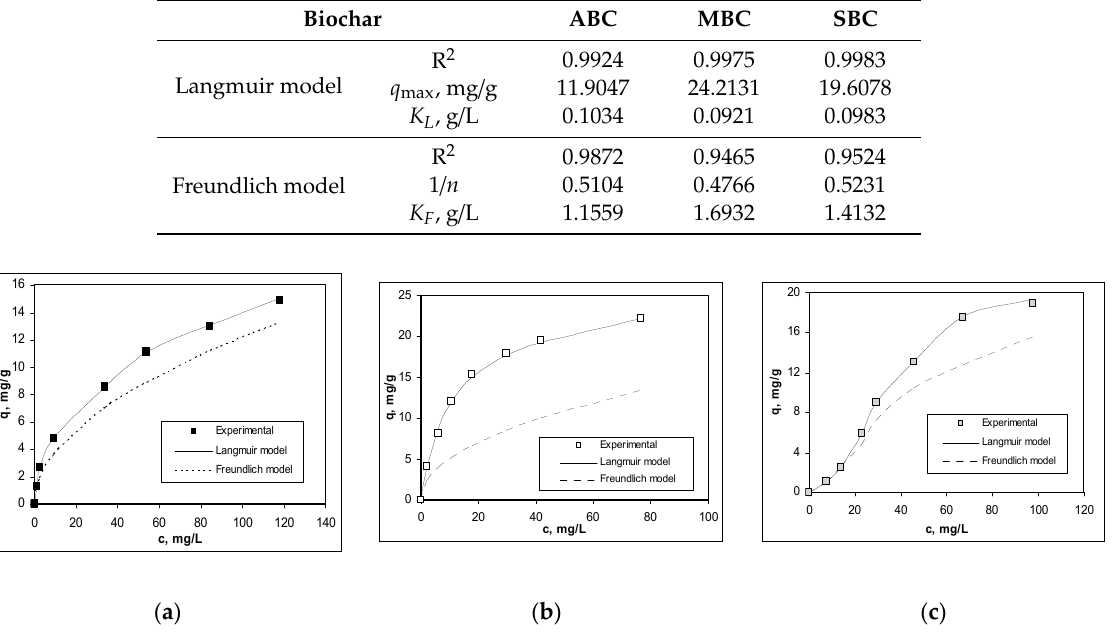
Figure 4. Isotherm modeling of Co(II) ions sorption on ( a ): ABC, ( b ): MBC, and ( c ) SBC (Experimental conditions: Initial pH = 5.0; 8.0 g biochar/L; contact time = 24 h; 25 °C).